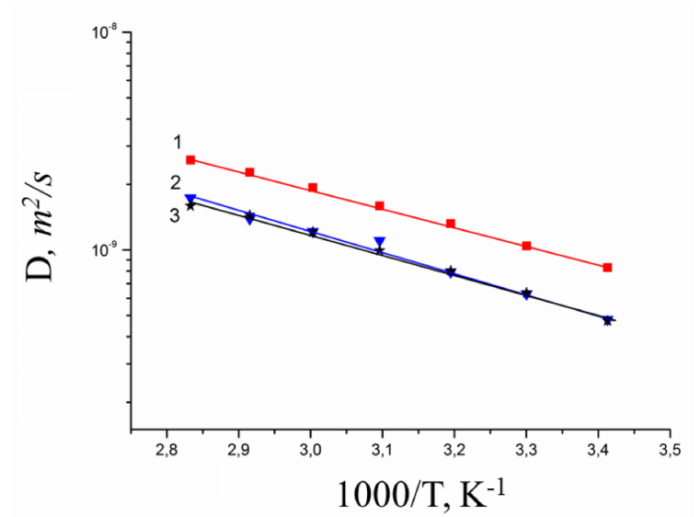
Figure 6. Temperature dependences of Cs + , Na + , and Li + di ff usion coe ffi cients in appropriate ionic form of MSC membrane at RH = 95%: 1–Cs + ionic form, Ea = 18.1 kJ / mol; 2–Na + ionic form, Ea = 16.5 kJ / mol; 3–Li + ionic form, E a = 17.6 kJ /